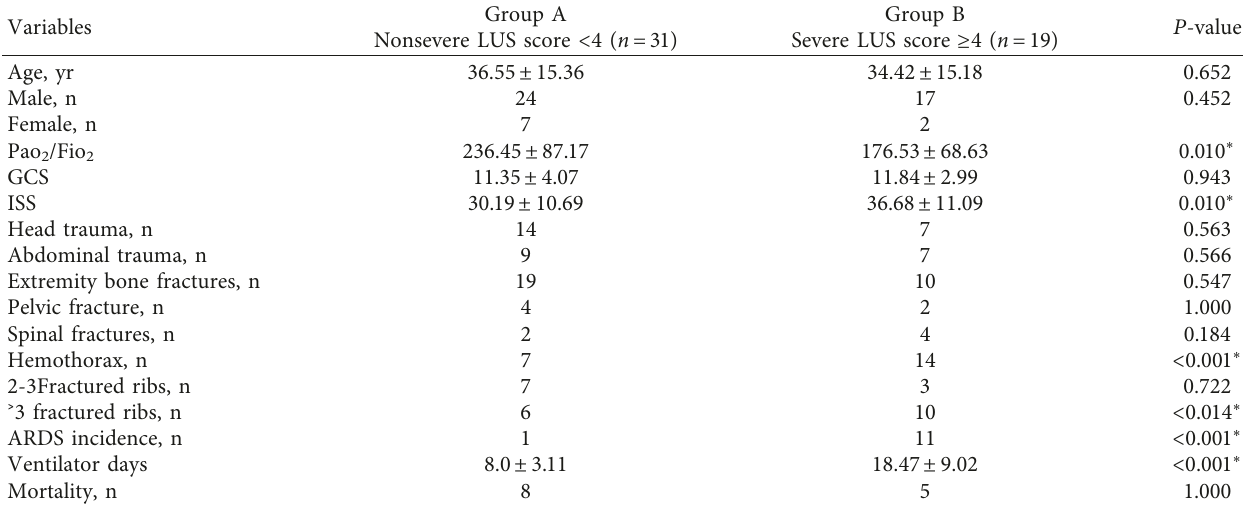
Figure 7: ROC curve for contusion score US to discriminate ISS ( > 24). Table 4: Severe and nonsevere lung contusion group characteristics.